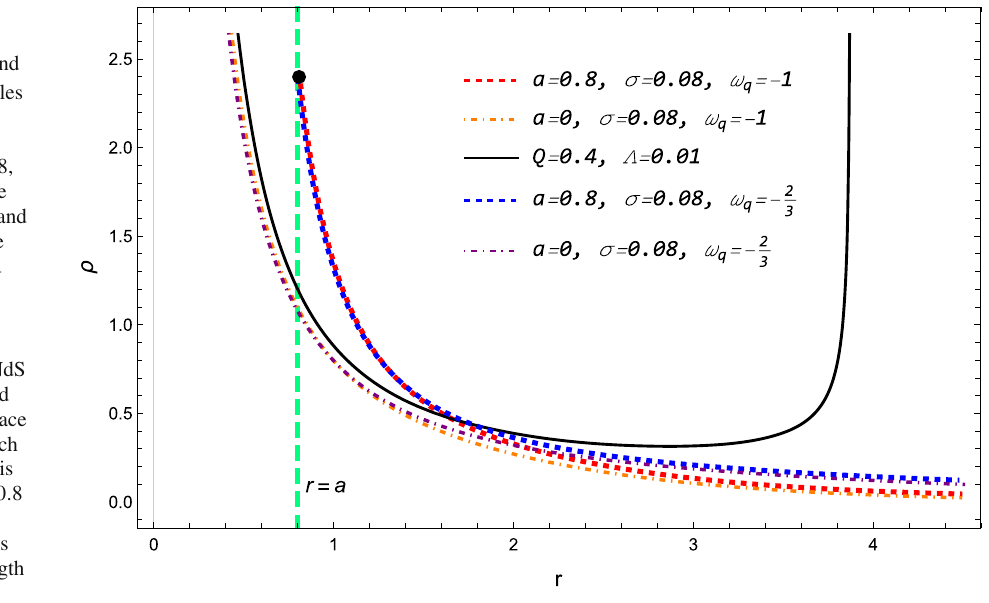
Fig. 4 The illustration of ρ versus r for RNKSK, RNdS, IKSK, KSL with ω q = − 1, and black holes KSL with ω q = − 2 3 in which we have set M = 1, B 3 = ˜ B 3 = 1, B 4 = ˜ B 4 = 1, Q = 0 . 4, (cid:12) = 0 . 01, σ = 0 . 08, and a = 0 . 8. The red and blue dashed lines are for RNKSK and IKSK cases, respectively. The orange and purple dot-dashed lines are for KSL with ω = − 1, and KSL with q = − 2 ω cases, respectively. q 3 The thick black line is for RNdS case. Finally, the green dashed line is the location of the surface of the central 2-sphere at which the RNKSK and IKSK cases is bounded. The choice of a = 0 .